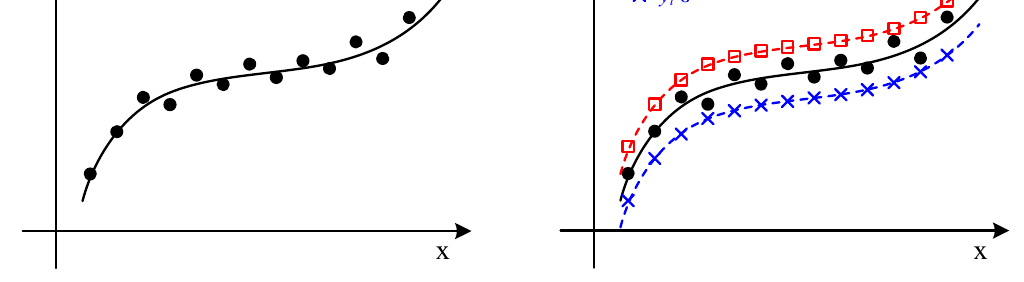
Figure 1. Schematic diagram of ε -Support Vector Regression (SVR).